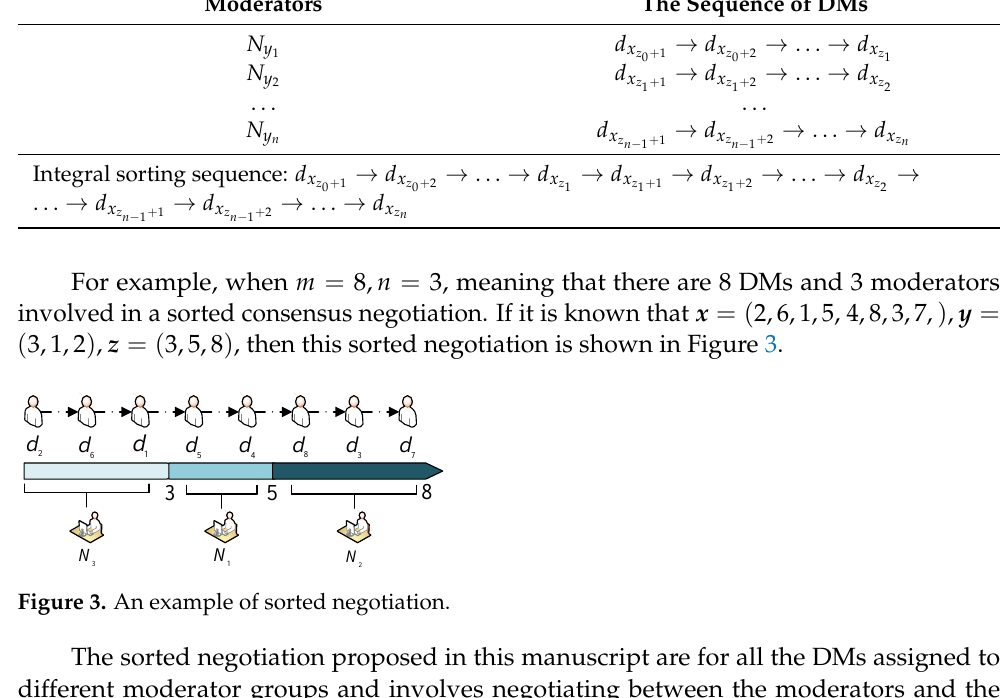
Table 1. The relationship of sorting sequence about moderators and DMs. Moderators The Sequence of DMs